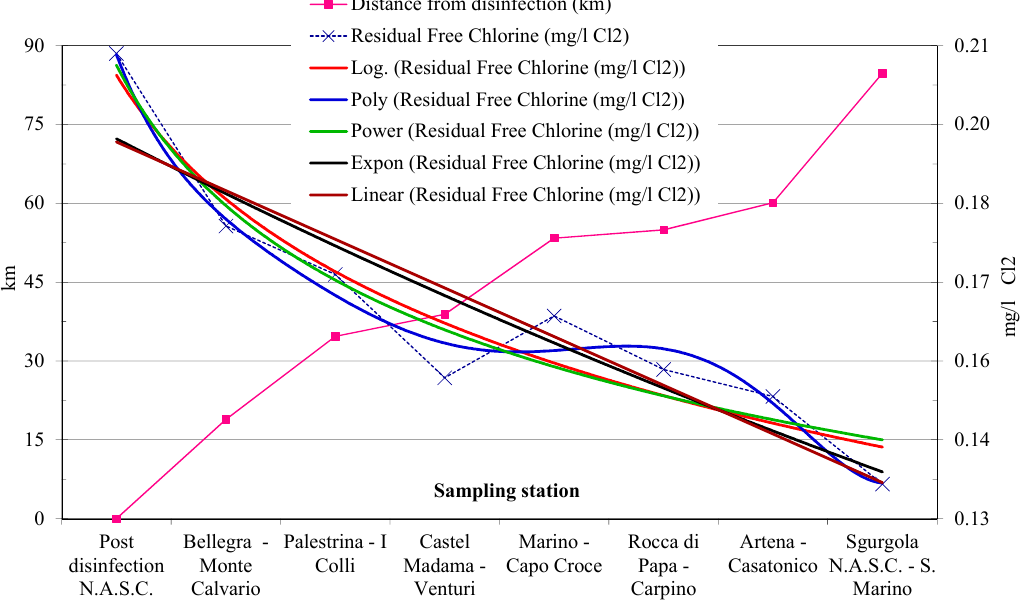
Figure 2. Water quality (temperature, pH, nitrates, turbidity, Kubel oxidability, free chlorine, total and fecal coliforms, fecal streptococci colonies on agar at 22 °C and 36 °C) observed in sampling stations (one after the other).